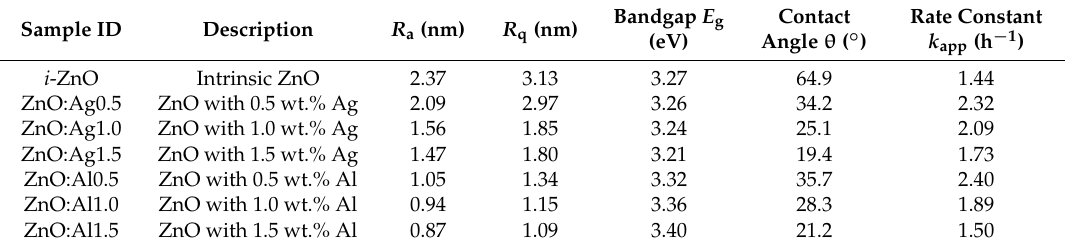
Table 1. Sample identification scheme, surface roughness parameters, and other properties of intrinsic and doped ZnO